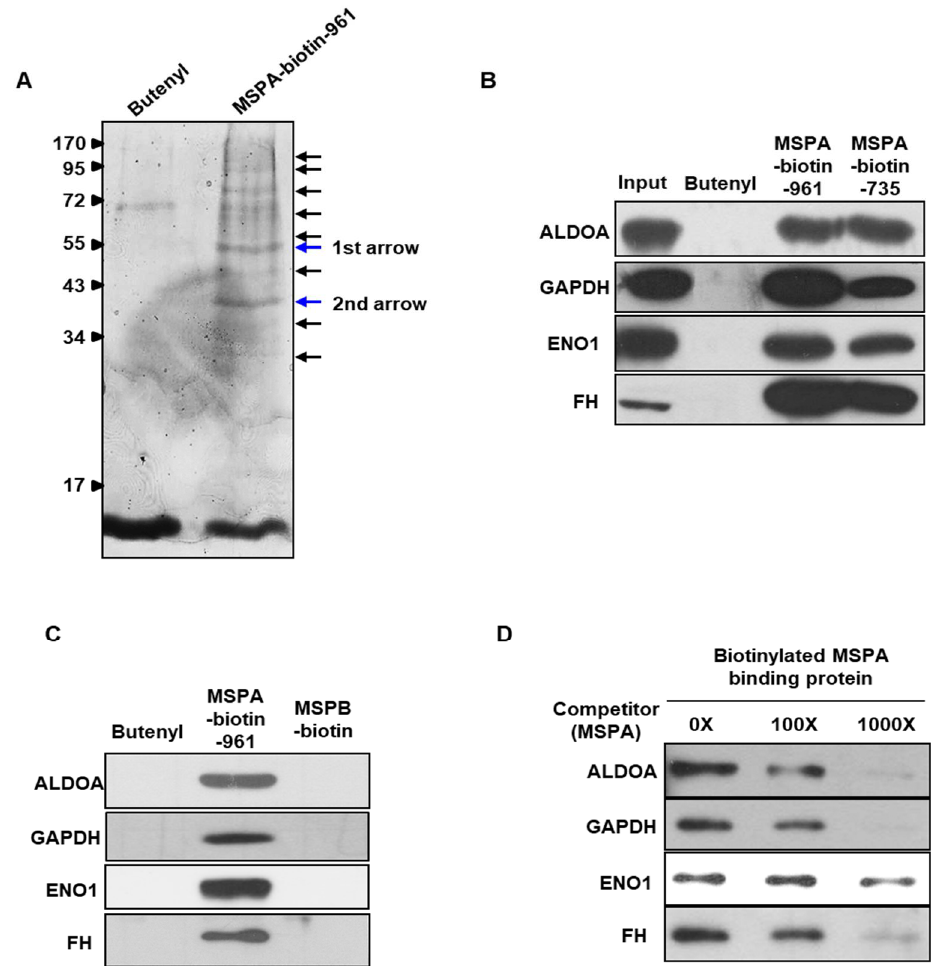
Figure 2. ( A ) Analysis of the putative target proteins of MSPA by Coomassie-stained SDS-PAGE analysis. Bands submitted to in-gel tryptic digestion for further mass spectrometric analysis are marked with blue arrows (first arrow and second arrow). Standard molecular weight (kDa) is on the left. ( B ) Detection of the interaction between biotinylated MSPA (or butenylated biotin, MSPA biotin-961, or MSPA biotin-735) and aldolase A ( ALDOA ), glyceraldehyde 3-phosphate dehydrogenase ( GAPDH ), enolase 1 ( ENO1 ), and fumarate hydratase ( FH ) proteins. ( C ) Results of an in vitro binding assay to determine interactions between MSPA and ALDOA , GAPDH , ENO1 , and FH ; biotinylated MSPB was used as negative controls. ( D ) The binding specificity of MSPA in target proteins was confirmed using a competitive binding assay. Excess non-biotinylated MSPA (0× (12.5 μM), 100× (125 μM), and 1000× (1.25 mM)) was added to HL60 cell lysates as a competitor of biotinylated MSPA.